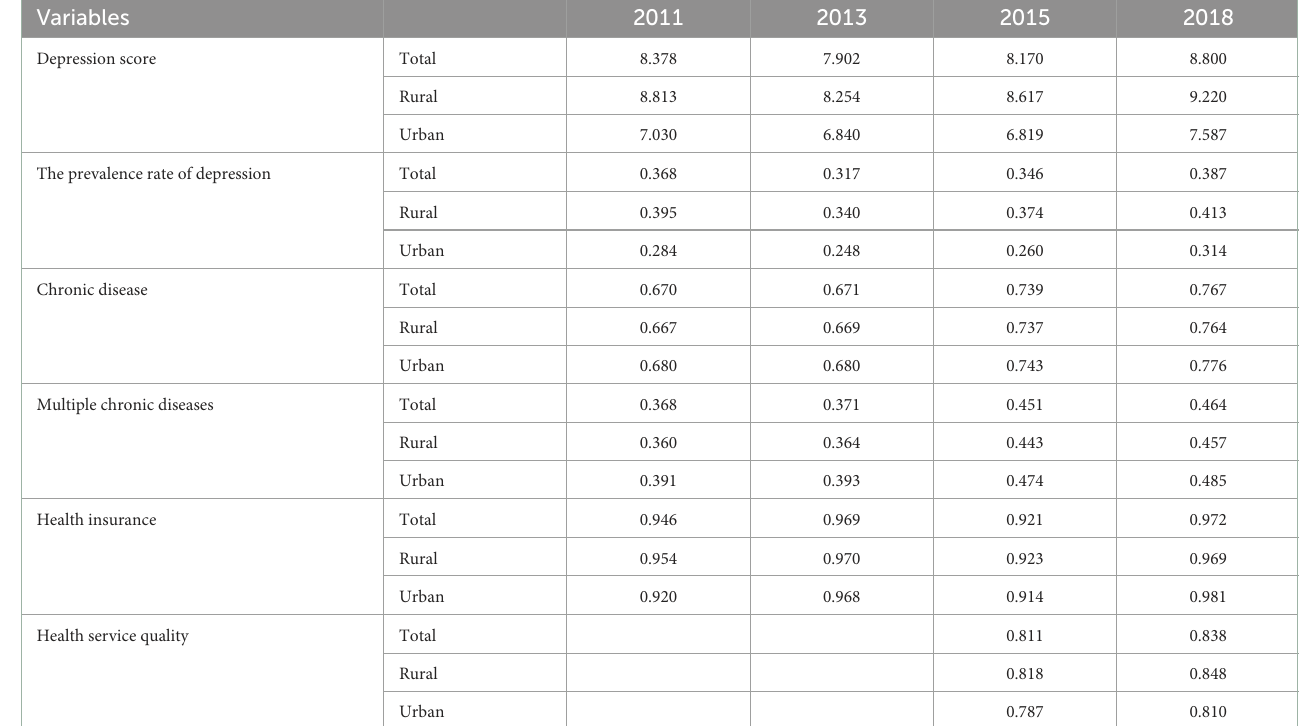
TABLE 2 Key variables and